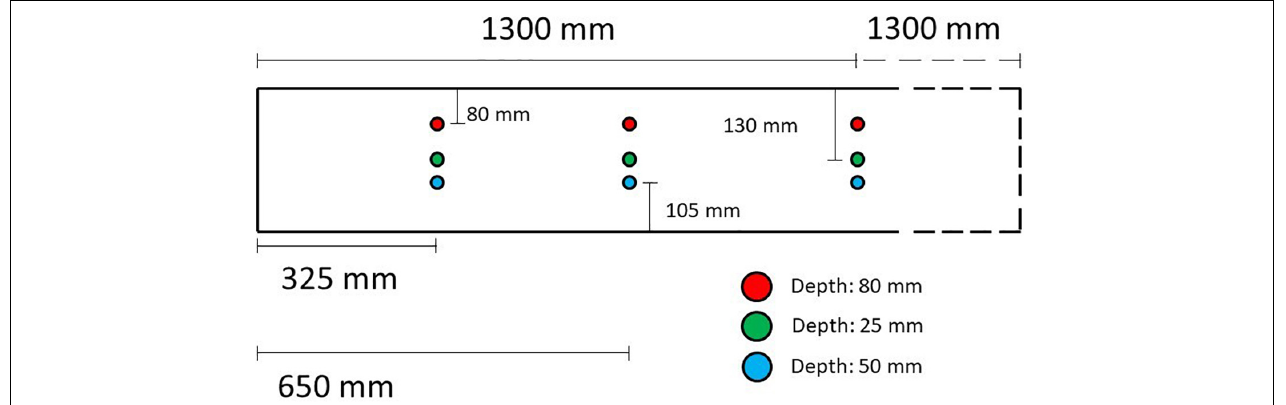
FIGURE 2 | Schematic overview of the measuring points for continuous moisture content measurements.